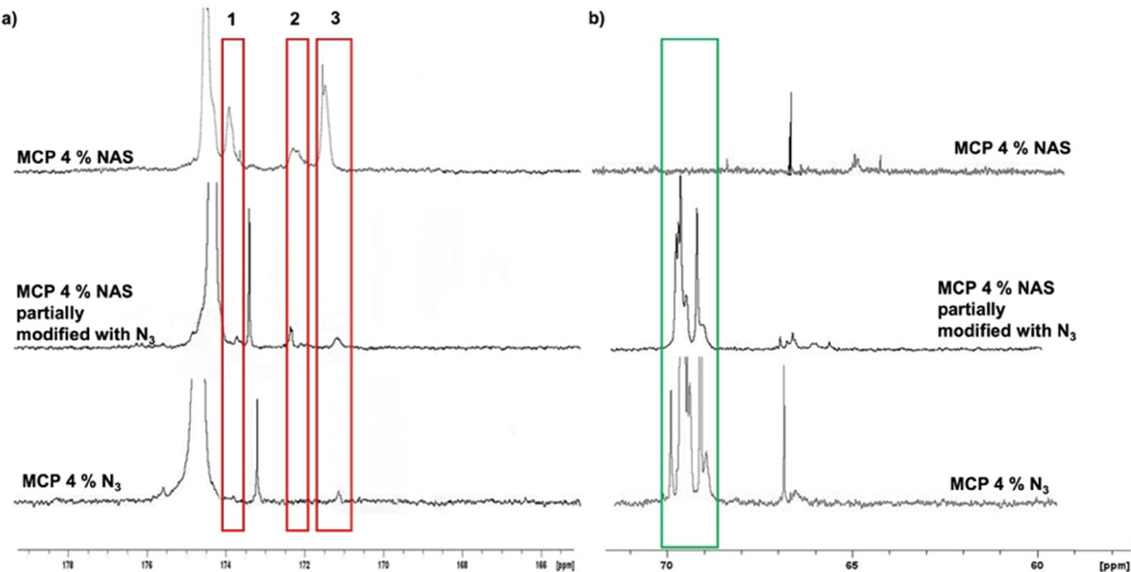
Figure 3. 13 C spectrum of the ( a ) carbonyl and ( b ) aliphatic region of MCP 4%NAS, MCP 4%NAS partially modified with azide groups, and MCP 4% N 3 . ( a ) The signals in the red rectangles correspond to the carbonyls of the succinimide group (NAS). It can be observed that these peaks disappear in the spectrum of MCP 4% N 3 since the NAS groups are totally substituted by azide moieties, demonstrating the absence of impurities, which remain in the case where the conversion is not completed (MCP 4%NAS partially modified). ( b ) The peak in the green rectangle represents the PEG signal which is absent in the MCP 4% NAS, while it appears when the 11-azido-3,6,9-trioxaundecan- 1-amine linker is inserted in the polymer chain to convert NAS into azide